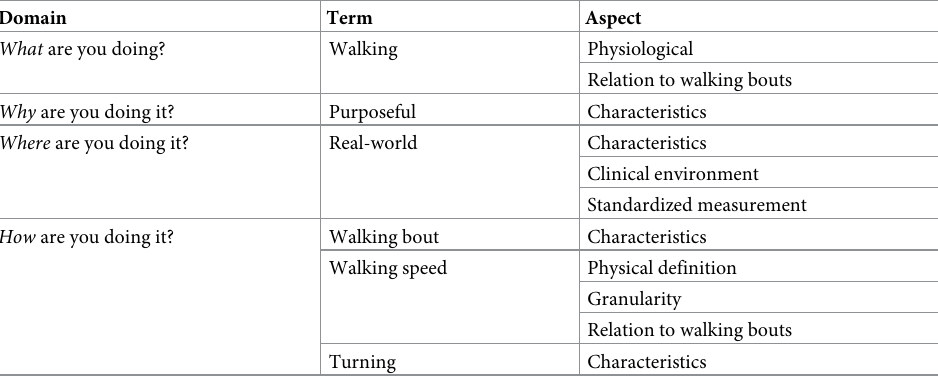
Table 1. Identified domains and terms needing